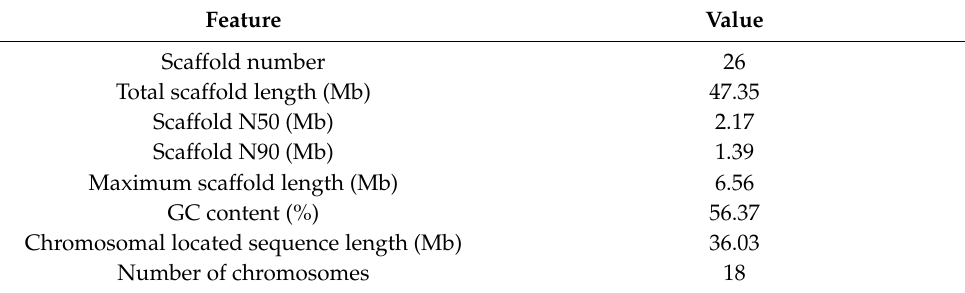
Table 1. Summary of genome assembly and annotation in isolate